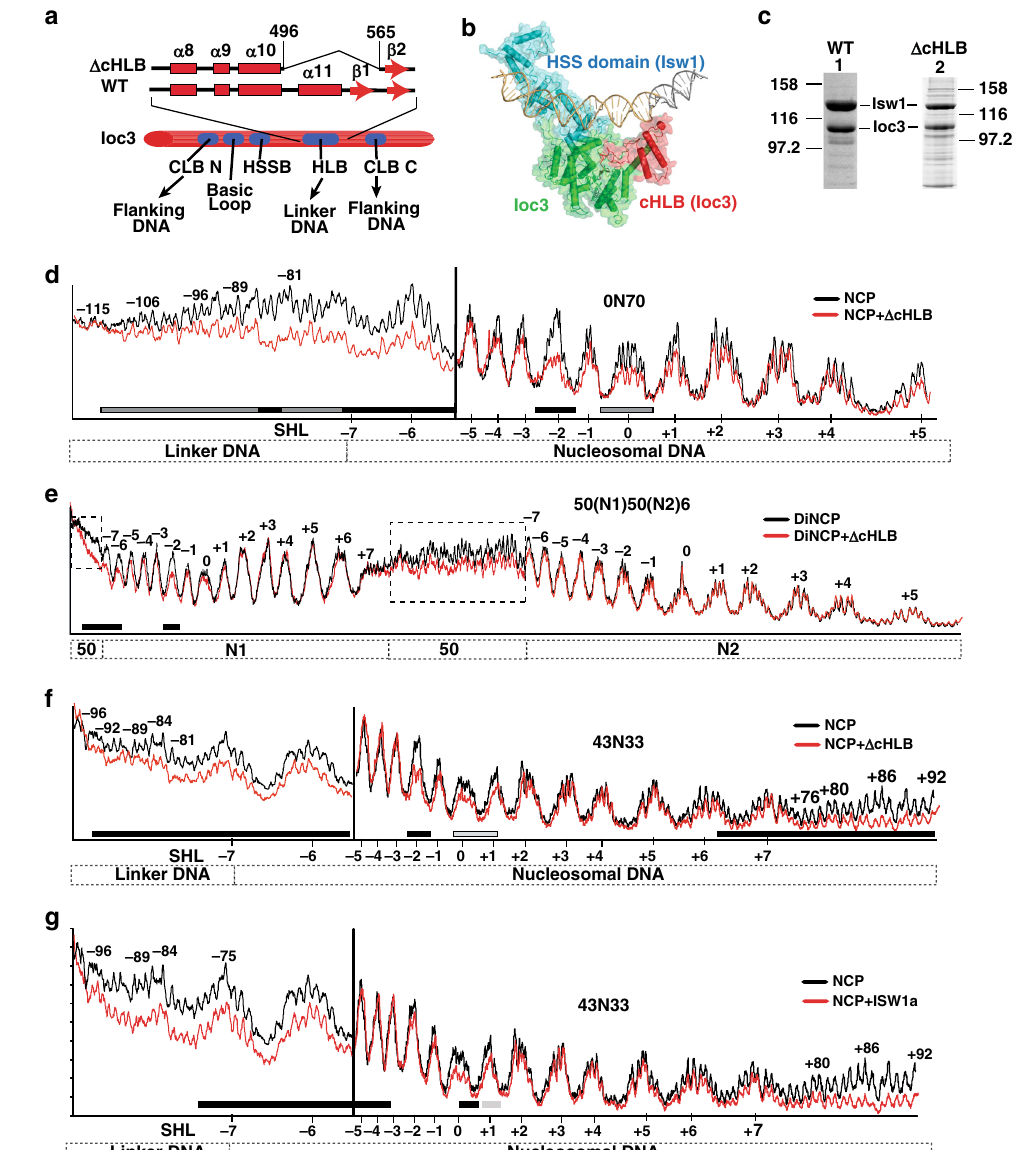
Fig. 5 Binding of the HLB domain of Ioc3 to extranucleosomal DNA is required for ISW1a to bind dinucleosomes. a The HLB domain of Ioc3 (red) was partially truncated as depicted to disrupt its binding to extranucleosomal or linker DNA. Ioc3 domains are shown in blue. b The crystal structure of truncated ISW1a with free DNA is shown and the region of HLB that was deleted in red 6 . The HSS domain of Isw1 (cyan) and Ioc3 (green) are shown. c Wild-type and mutant ISW1a with the C-terminal end of HLB deleted ( Δ cHLB) were analyzed by SDS-PAGE and stained with Coomassie blue. d – g The interactions of Δ cHLB ISW1a with ( d ) 0N70, ( e ) 50(N1)50(N2)6 and ( f ) 43N33 nucleosomes or ( g ) wild-type ISW1a with 43N33 nucleosomes were analyzed by DNA footprinting with hydroxyl radicals. Black traces are nucleosome alone and red are the nucleosomes fully bound by wild-type or mutant ISW1a. DNA footprinting experiments had a minimum of 2 – 3 replicates with similar results as those depicted. Source data are provided as a Source Data fi 6-aza-uridine (6 AU) resistant, sensitive to rapamycin and defective in TOR signaling as observed previously for isw1- Δ yaf9 Δ (Fig. 8a) 3,4 . We also found that ISW1a is important for using alternative carbon sources other than dextrose using the same double mutants as before (Fig. 8b). Strikingly the defects seen with the ioc3 Δ cHLB yaf9 Δ double mutant in all of these assays phenocopied that of the ioc3 Δ yaf9 Δ double mutant.